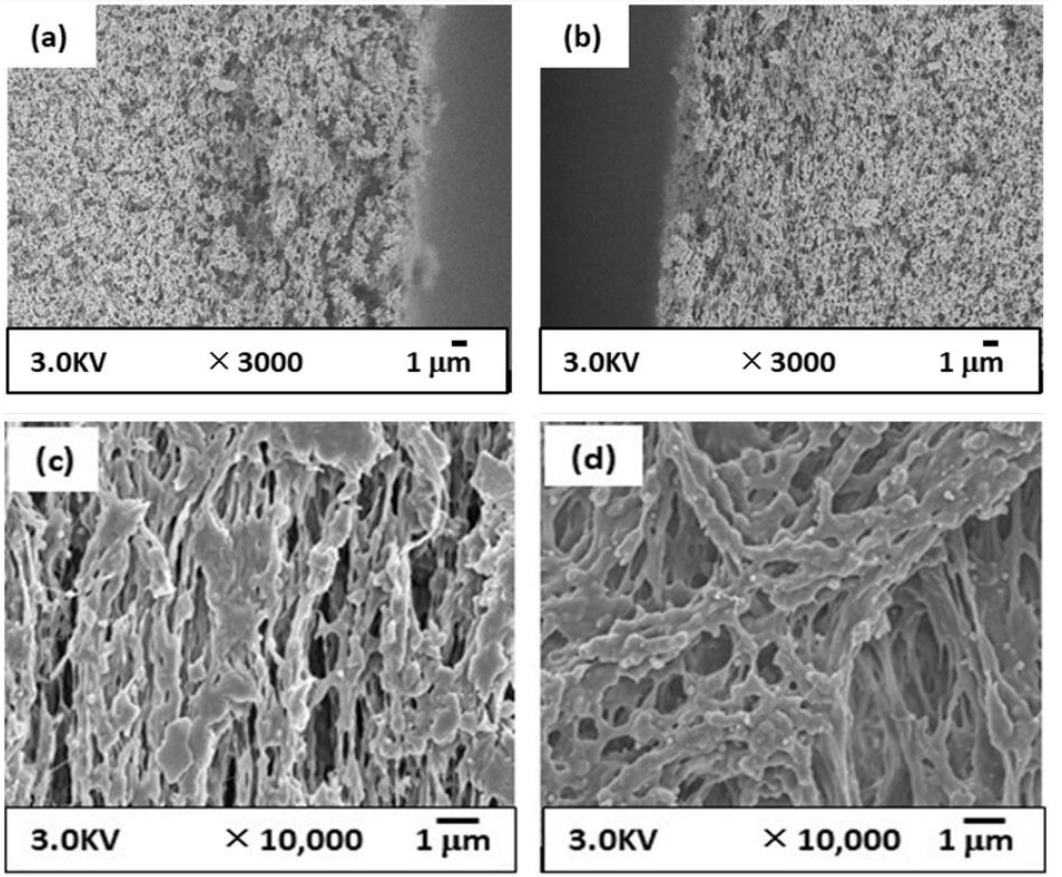
Figure 4. SEM images of prepared CBzOH hollow fiber membranes prepared by TIPS method; ( a ): cross-section near the outer surface ( b ): cross-section near the inner ( c ) outer surface ( d ) inner surface.